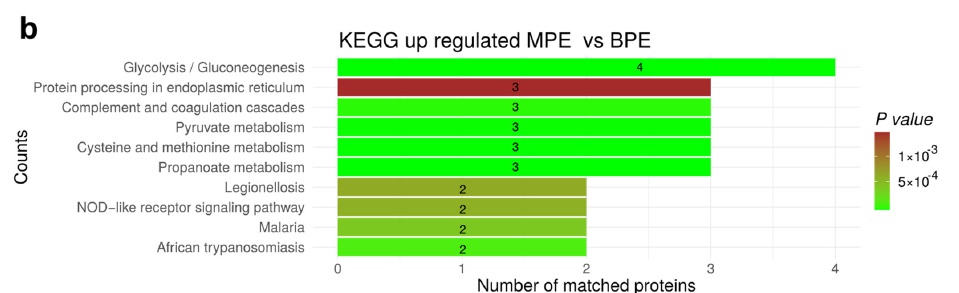
Figure A2. Functional analysis for significant up-regulated proteins by comparing MPE versus BPE proteome. ( a ) Shows the significant GO analysis of up-regulated proteins ( p -value < 0.05) between MPE and BPE (CC, Cellular component; BP, biological process; MF, molecular function), ( b ) KEGG pathway enrichment analysis for up-regulated proteins by comparing MPE and BPE.